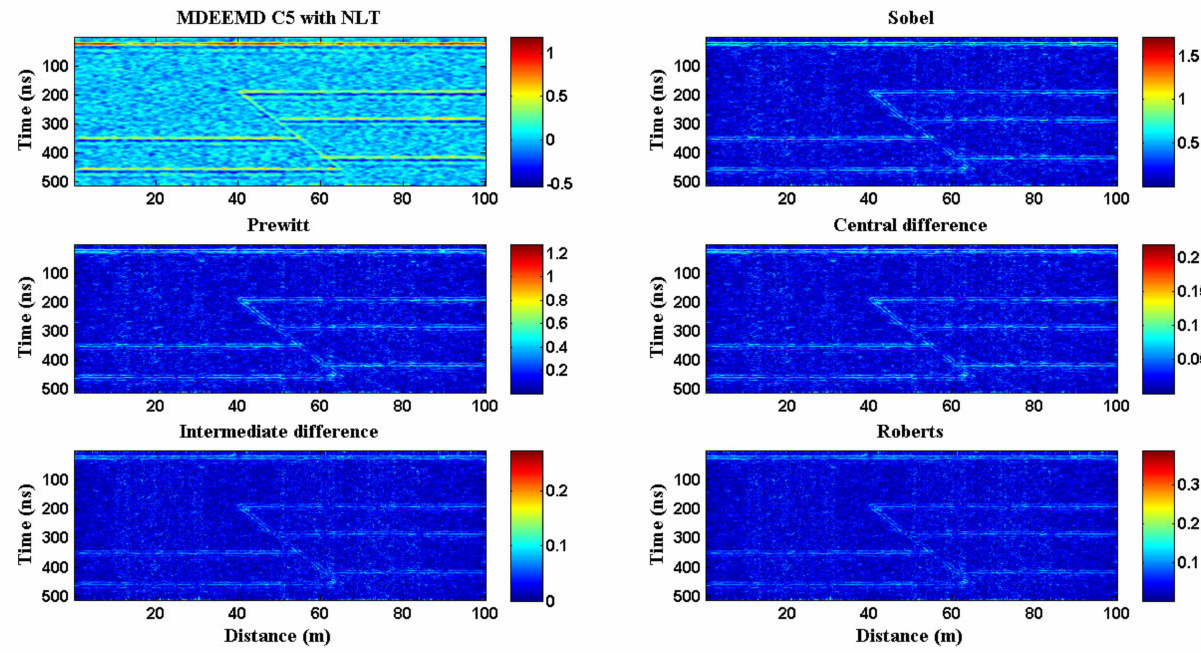
Figure 5. Two-dimensional edge maps of the hypothetical model study with MDEEMD. Various edge detectors are applied to the noise-corrupted profile after the MDEEMD processing, where component C5 with NLT, shown in Figure 3a, is used as the reconstructed profile for performing edge